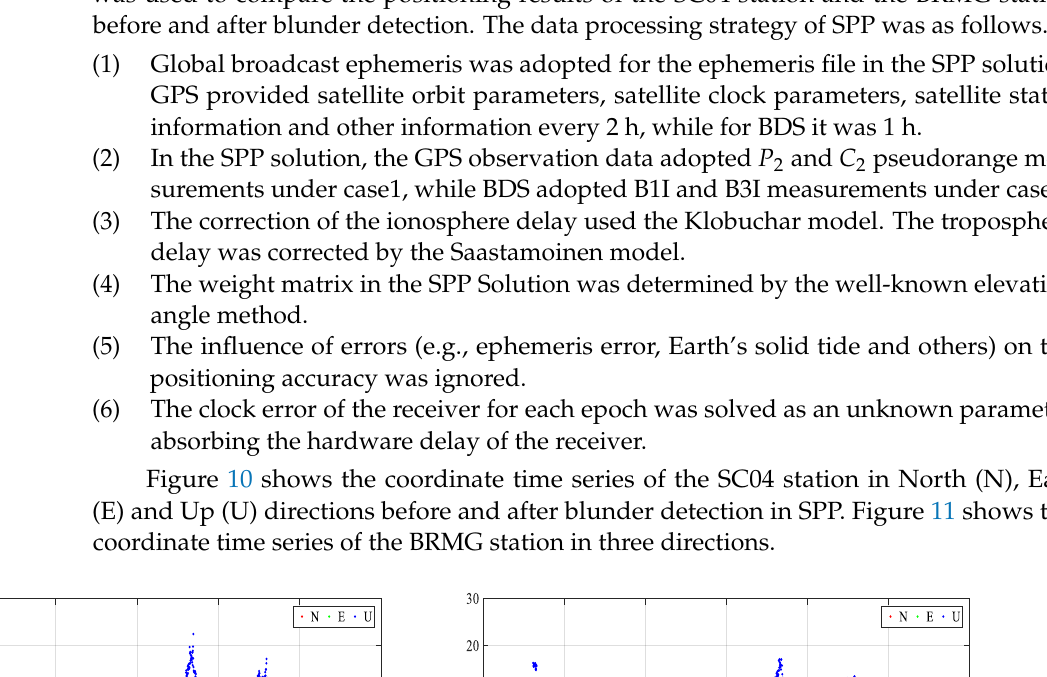
Figure 11. Time series of N, E and U directions of BRMG station based on BI1 and B3I observation data before (a) and after (b) blunder error detection.